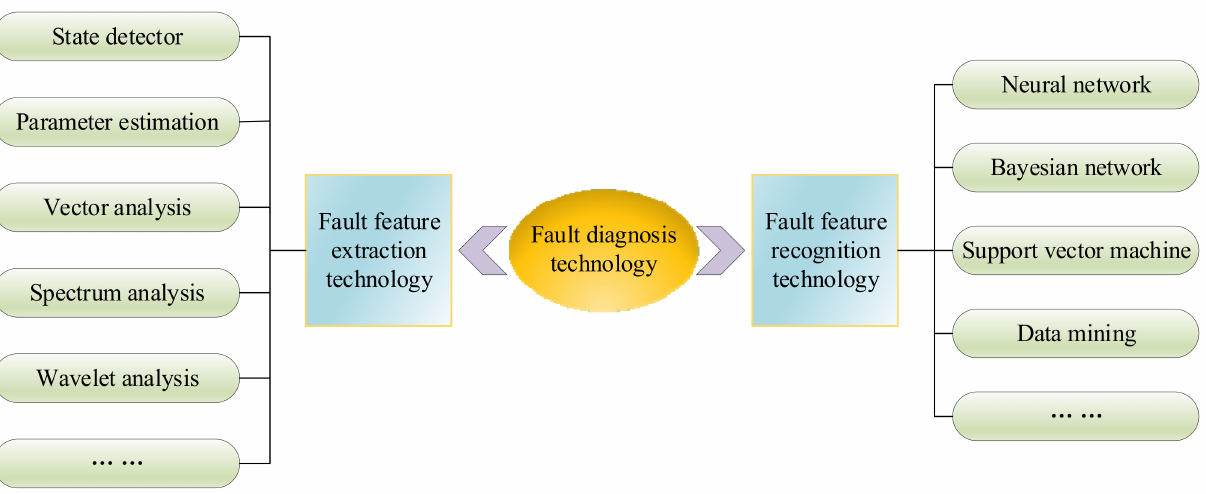
Figure 2. Classification of fault diagnosis